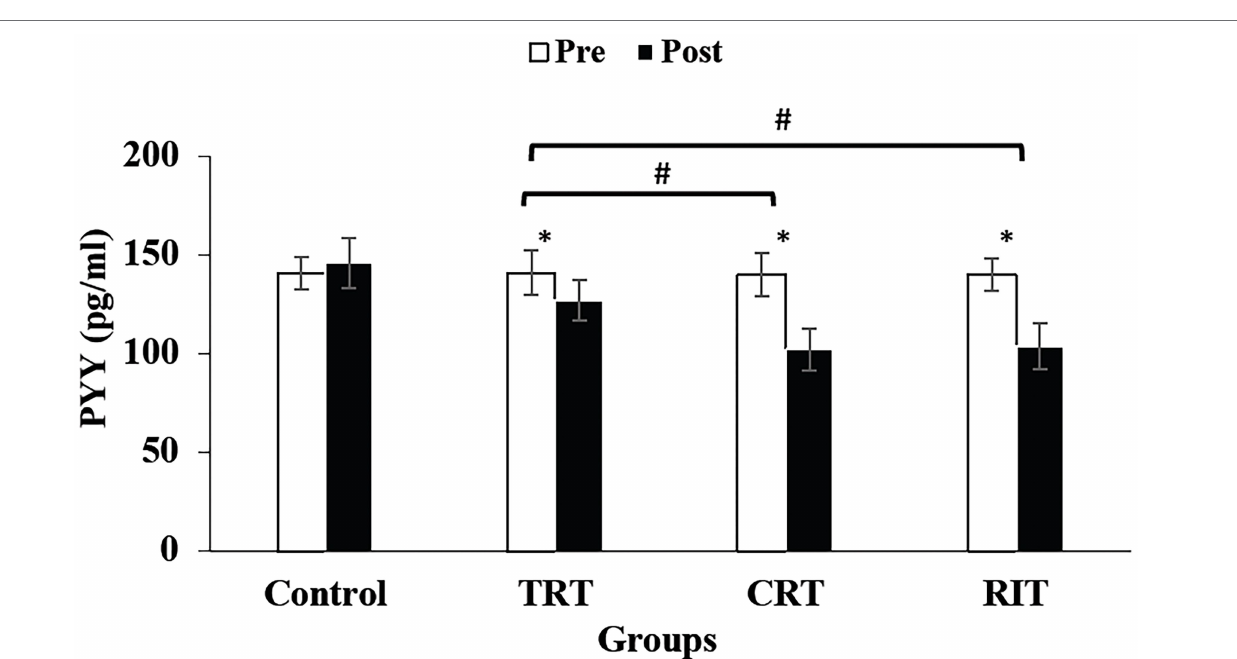
TABLE 3 | Pre- and post-values of leptin, adiponectin, ghrelin, CCK, GLP-1, GIP, PYY, and body composition at pre-and post-intervention. Control TRT CRT IRT Partial Pre